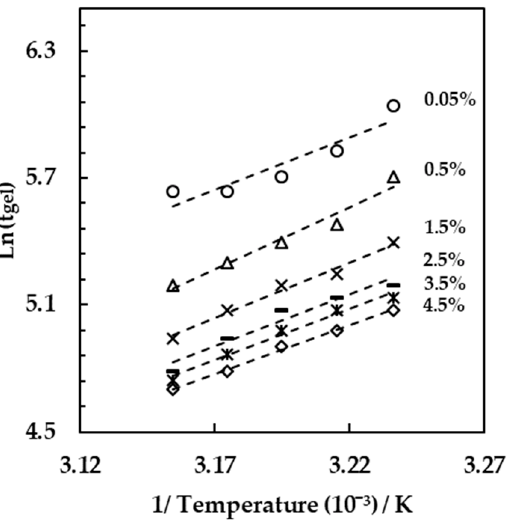
Figure 5. Natural log of the gel time plotted vs. the inverse of the incubation temperature.